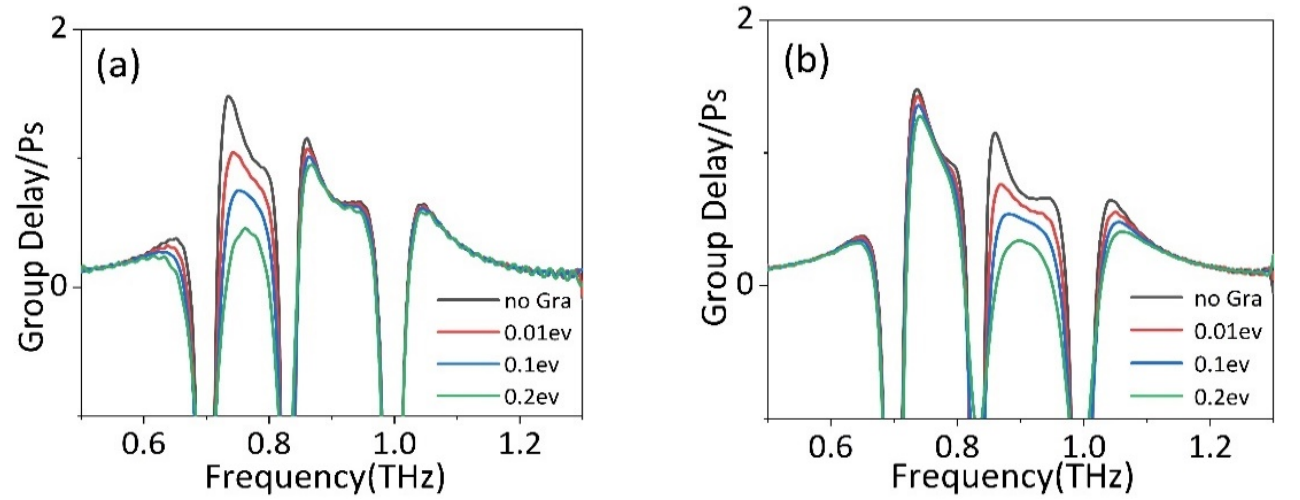
Figure 8. The group delay of PIT metamaterial with different Fermi level of ( a ) strip 2 and ( b ) strip 1.